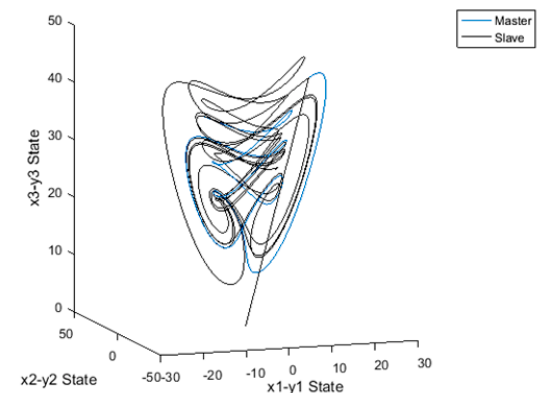
Figure 4. Phase space of synchronization of original master–slave system.